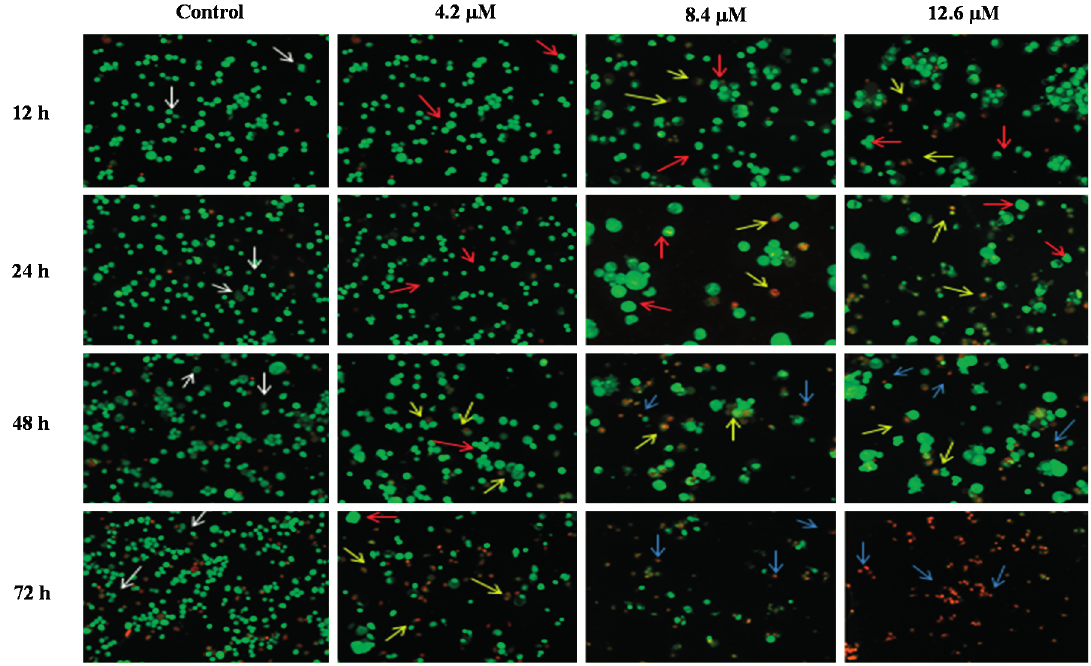
Figure 6. Detection by fluorescent microscopy of acridine orange/ethidium bromide double stained PC-3 cells treated with MS17 for 12, 24, 48 and 72 h. Untreated viable cells are uniformly pale-green (white arrow); Early apoptotic cells shows characteristic loss of membrane integrity and chromatin condensation, stained bright-green to yellow (red arrow); Late apoptotic cells stained yellow-orange or red colour, with a condensed or fragmented chromatin (yellow arrow); Necrotic cells showed bright orange-red in appearance (blue arrow). Magnification